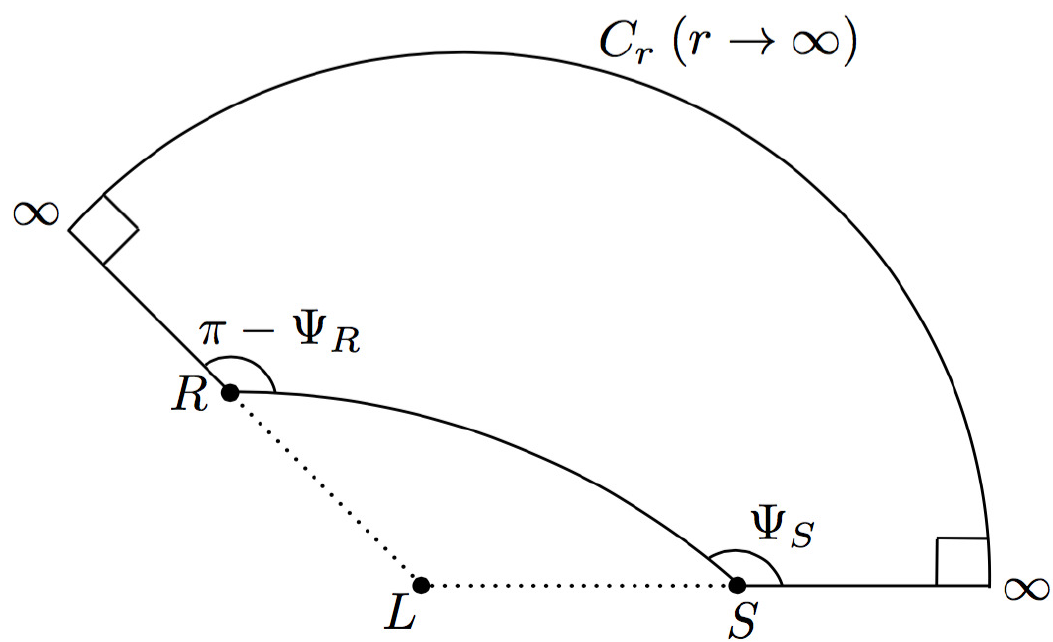
(cid:3) ∞ Figure 2. ∞ is a quadrilateral embedded in a curved R S